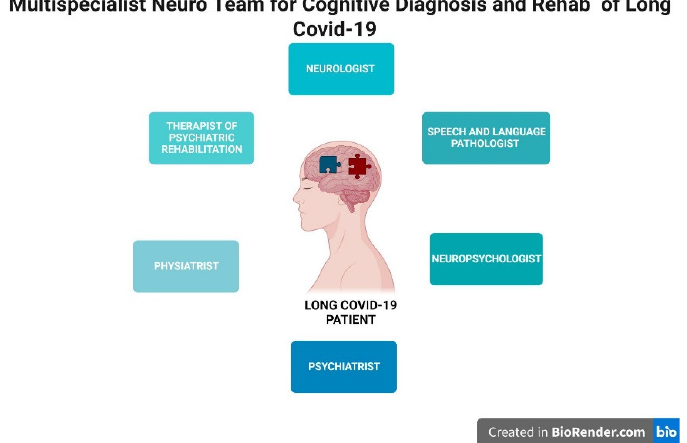
Figure 1. This represents the necessary healthcare figures for the cognitive diagnosis and rehabili- tation of Long COVID patients. Created with BioRender.com https://biorender.com/ (accessed on 13 September 2022) [110].